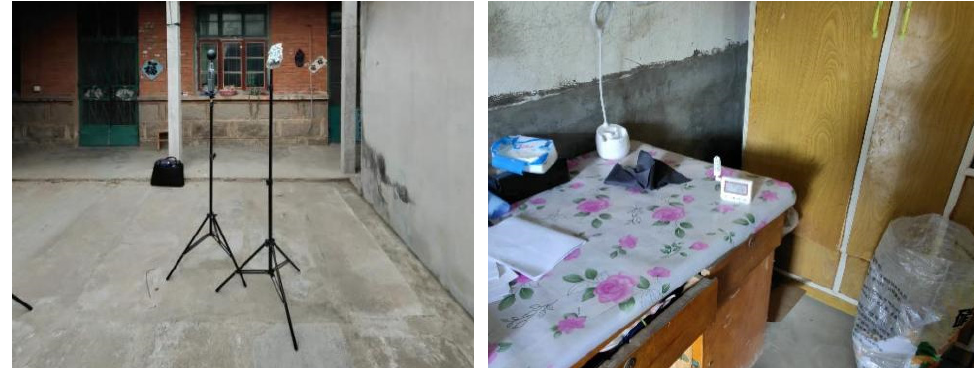
Figure 5. Field measurement.